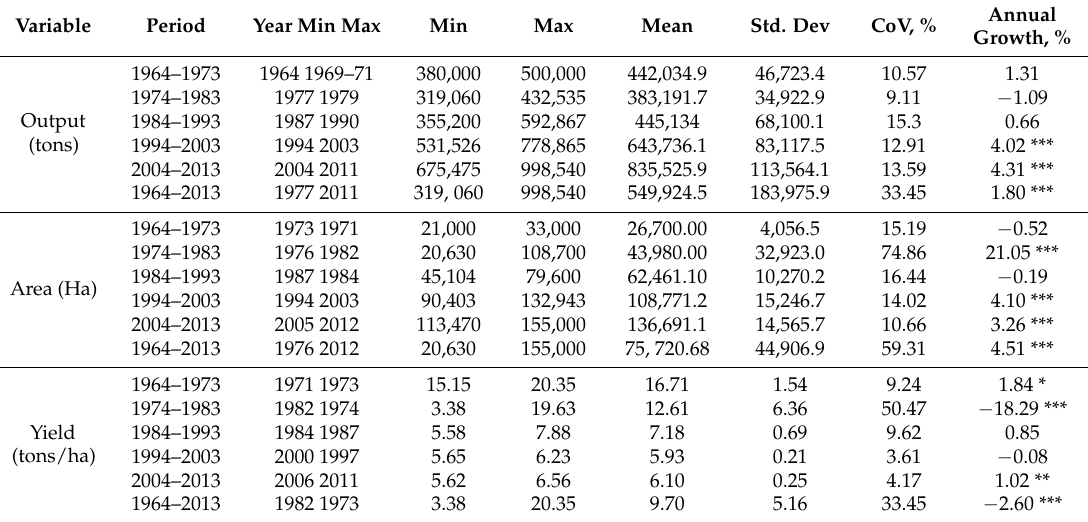
Table A1. Cassava production, acreage and yield statistics for Togo.